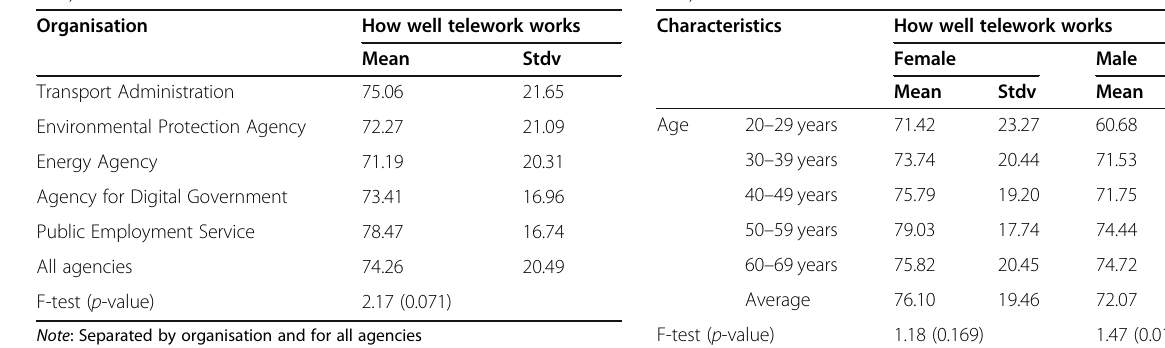
Table 6 Responses to the Question ‘ How Well Do You think Teleworking Works for You Now, During COVID-19 ” (Rating 1